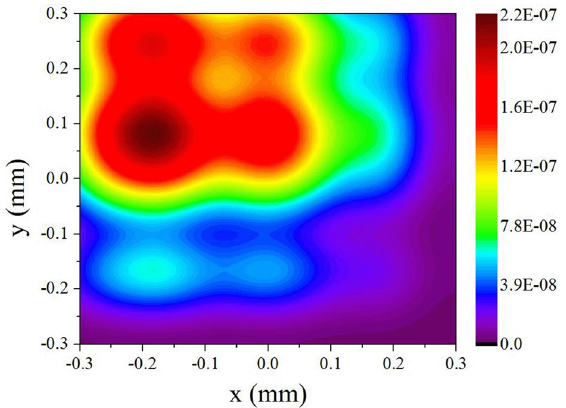
Figure 2. (Color online) System efficiency distribution map in the view field for the best channel of the eight- image KB